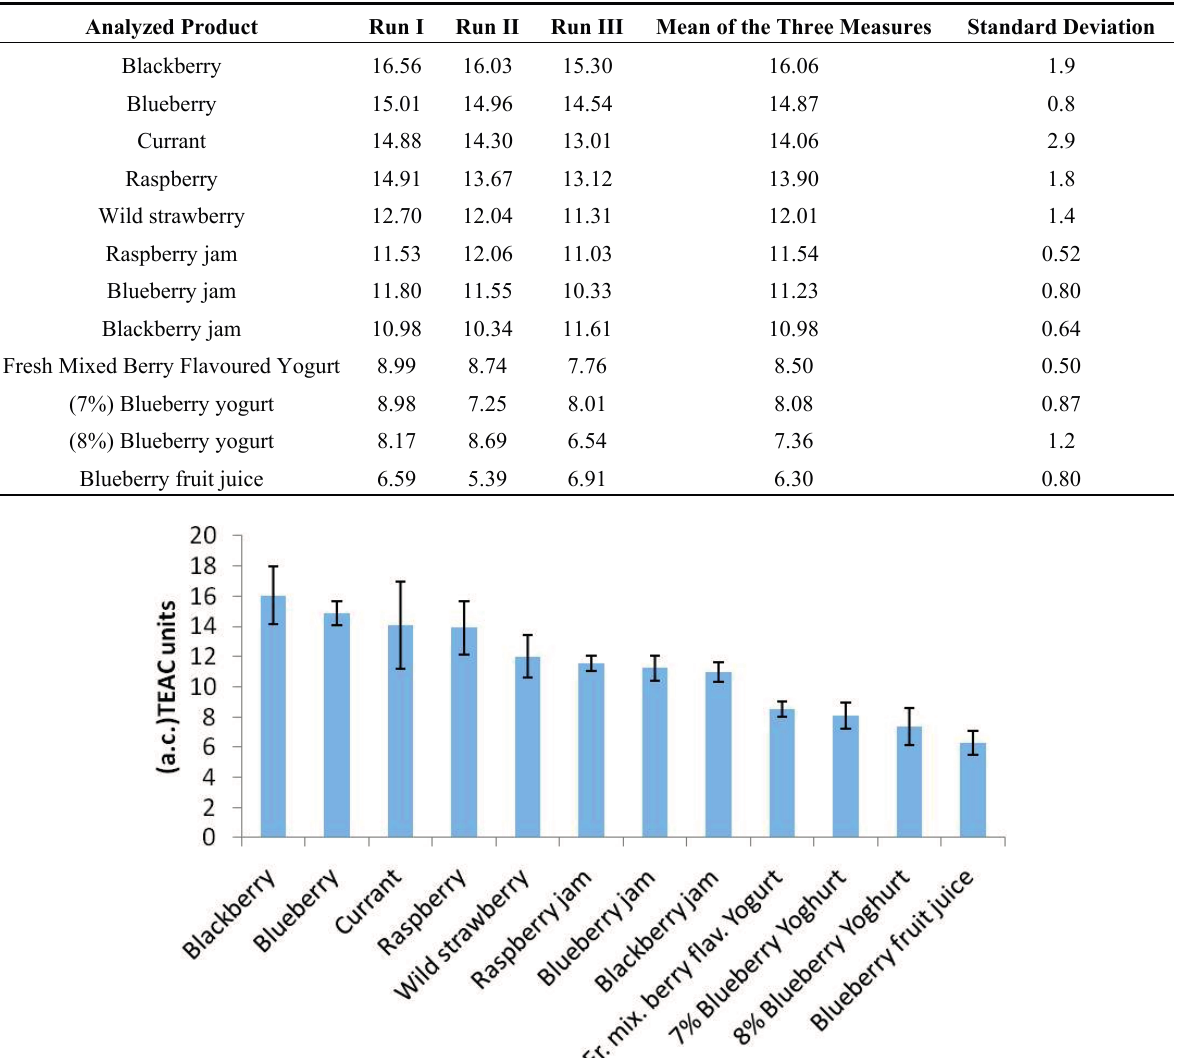
Table 4. Repeated test results using the DMPD-FeCl 3 spectrophotometric method, values expressed in TEAC units.